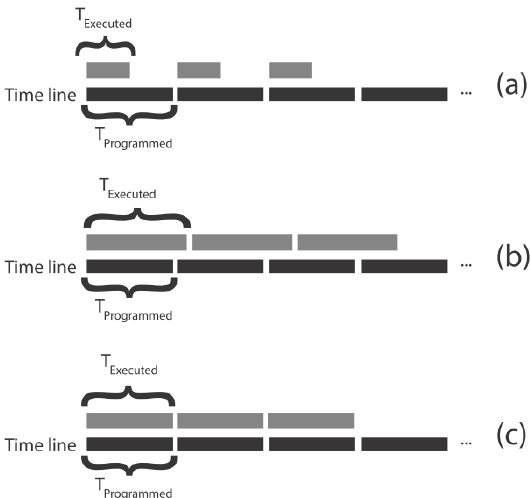
Fig. 3: Task execution diagram. (a) Task finished before dead- line: the available computing resources exceed task processing requirements (b) Delayed task (c) Optimal case.